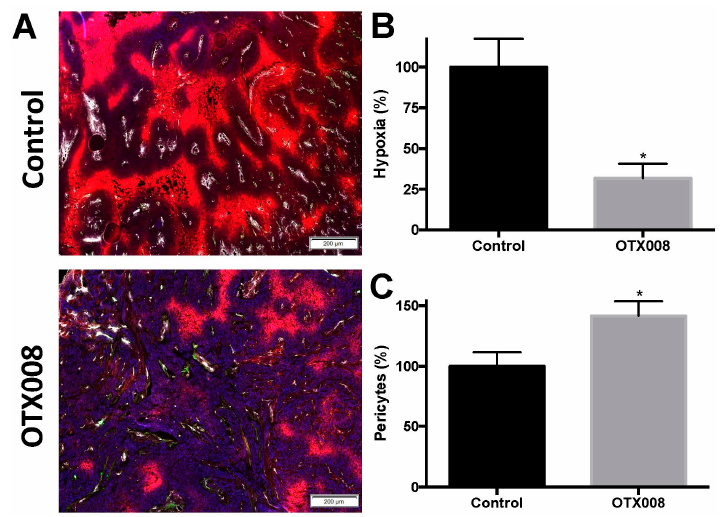
Figure 5. Hypoxia and pericyte content in SQ20B tumor tissue after OTX008 treatment. ( A ) Immunofluorescence analysis of SQ20B tumors cross-sections from OTX008 or vehicle treated animals at 14 days after the beginning of OTX008 therapy. Microvessel density is revealed by CD31 antibody staining (white), pericytes by alpha-smooth muscle actin ( α SMA; green) and hypoxia by pimonidazole (red). Magnifications as indicated; ( B ) Quantification of hypoxia by pimonidazole positive regions; ( C ) Quantification of pericytes by α -SMA positive cells. Data is depicted as means ± SEM and normalized to the controls, set at 100%; * p < 0.05 (Student’s t -test).